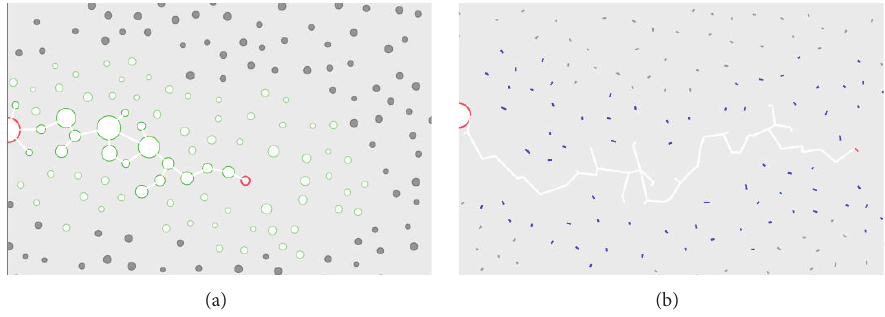
Figure 8: Java script visualization examples of crack growth on (a) micropores and (b) small